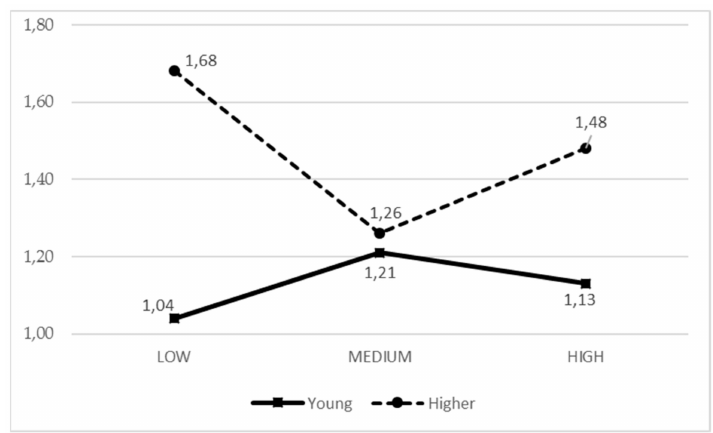
Figure 5. Means of the IPAF4 parental style based on the adolescent age for alcohol consumption.